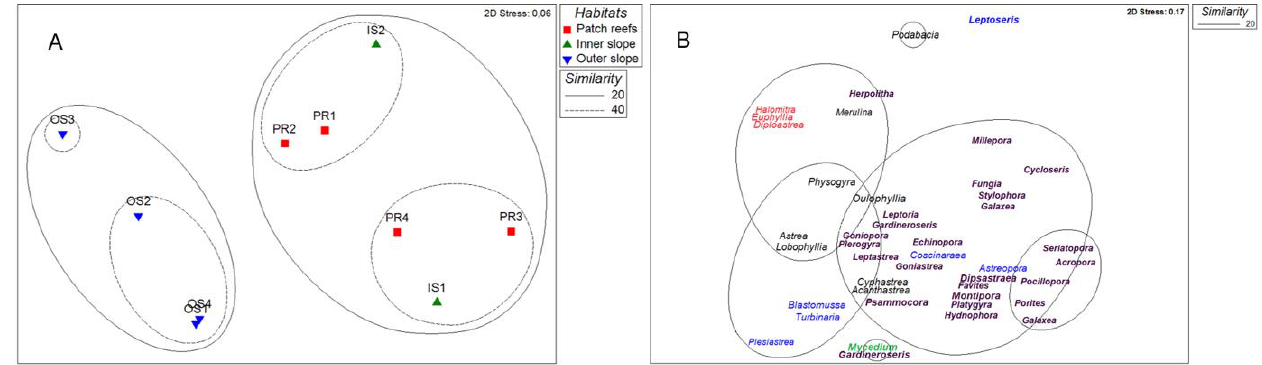
Figure 7. Non-metric multidimensional scaling (nMDS), based on the Bray-Curtis dissimilarity index, showing the spatial variation in the composition and abundance of coral assemblages among the 10 stations located on the three major habitats (PR: patch reefs, IS: inner slope, and OS: outer slope). Position of the 10 stations ( A ) and of the 43 genera ( B ) on the first two axes of the nMDS. The color code is as follows: red for patch reefs stations and coral genera exclusively recorded on this habitat, green for inner slope stations and coral genera exclusively recorded on this habitat, blue for outer slope stations and coral genera exclusively recorded on this habitat, coral genera recorded at all three habitats are indicated in purple, and coral genera recorded on more than two habitats are in black.